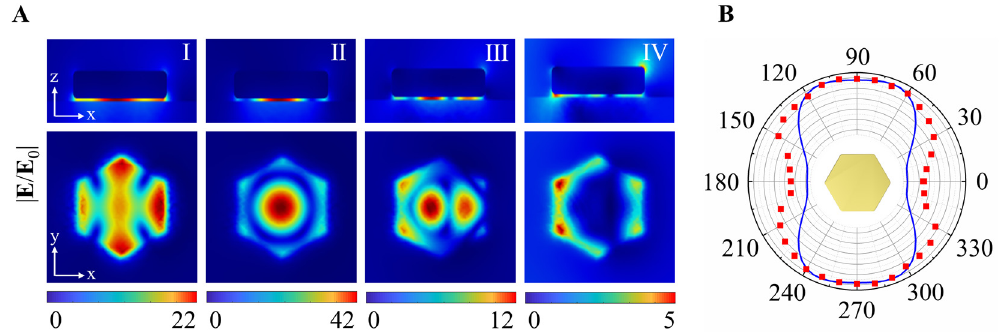
Figure 3: (A) Electric field enhancements of modes I – IV for a hexagonal Au NPoM with d = 185 nm and g = 5 nm. (B) Polar plot of the polarization-dependent scattering intensity of the fundamental radial breathing mode (RBM, mode II). The blue solid line and red dots are derived from the simulation and experiment,